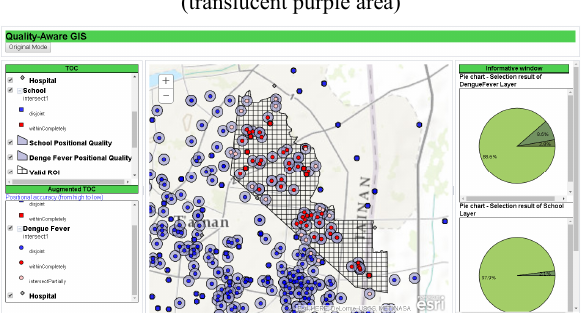
Figure 13. Result of select by region operation (with positional accuracy consideration) – symbol transformation